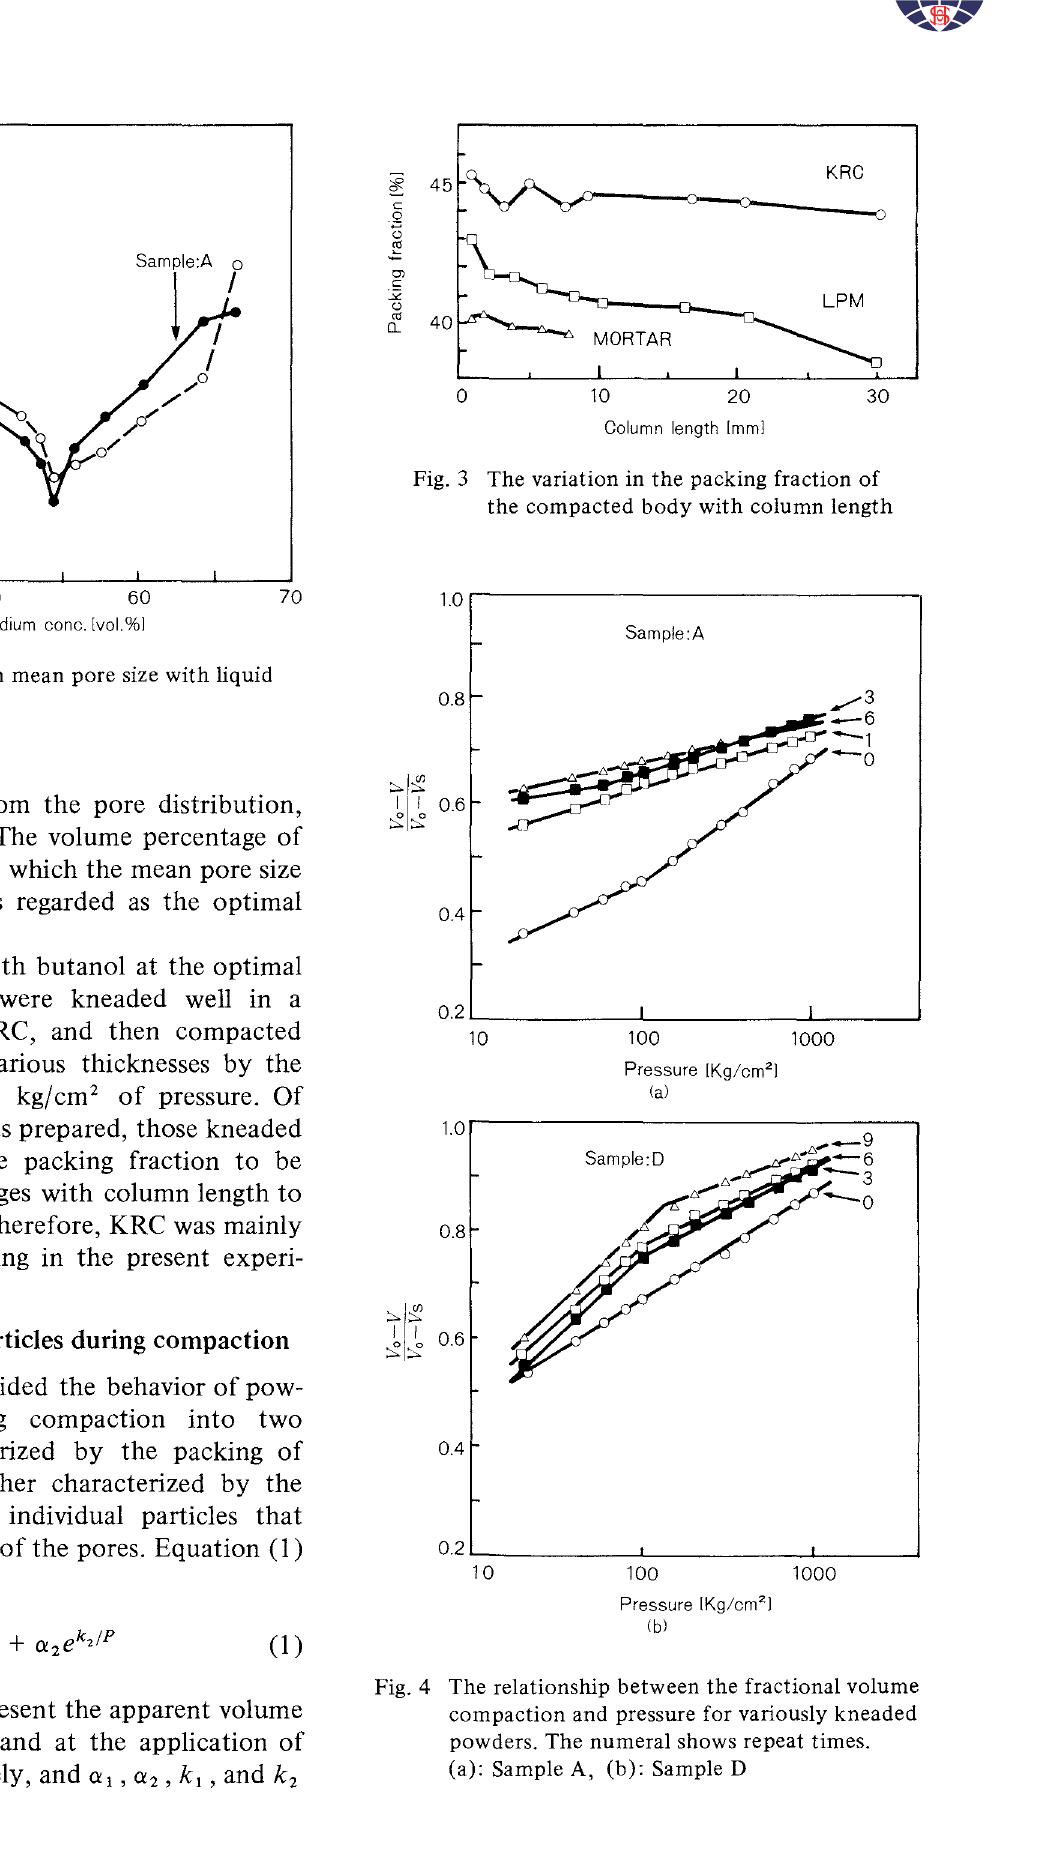
Fig. 4 The relationship between the fractional volume compaction and pressure for variously kneaded powders. The numeral shows repeat